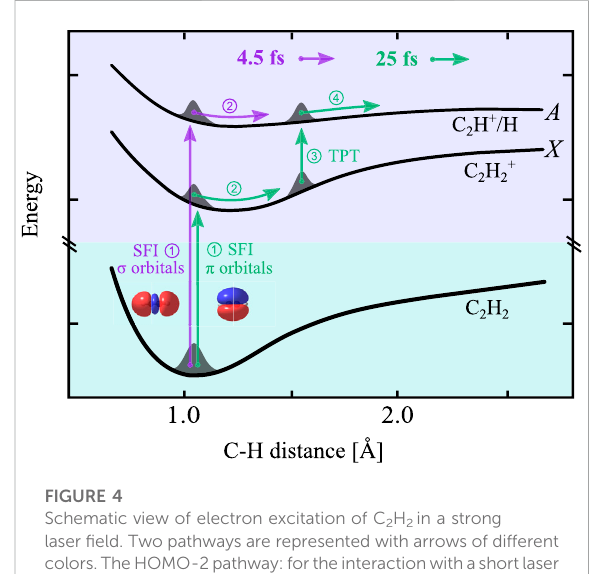
FIGURE 4 Schematic view of electron excitation of C 2 H 2 in a strong laser fi eld. Two pathways are represented with arrows of different colors.TheHOMO-2pathway:fortheinteractionwithashortlaser pulse with a pulse duration shorter than the C-H vibrational period, strong fi eld ionization (SFI) of a HOMO-2 electron directly leads to the electronically excited and dissociative A state. The HOMO pathway: for the interaction with a long laser pulse with a pulse duration longer than the C-H vibrational period, fi rst, an electron is removed from the HOMO which launches a vibrational wave packet on the potential surface of the C 2 H + 2 ground state. The vibrational wave packet moves toward a larger C-H distance and resonant three-photon transition (TPT) occurs once the energygap fi tstheenergyofthree800-nmphotons.Thepotential energy curves are adapted from Ref.